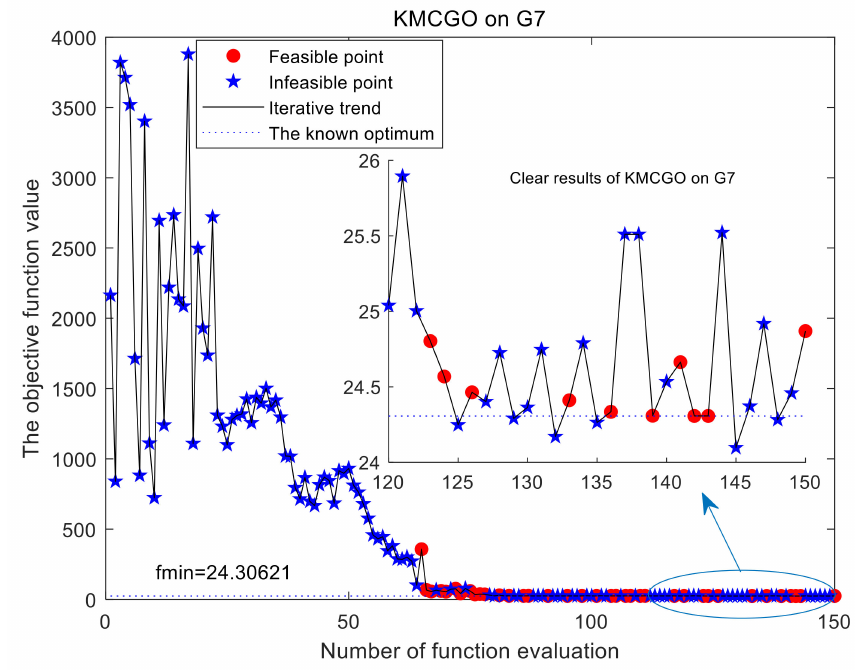
Figure 12. Iteration result of the G7